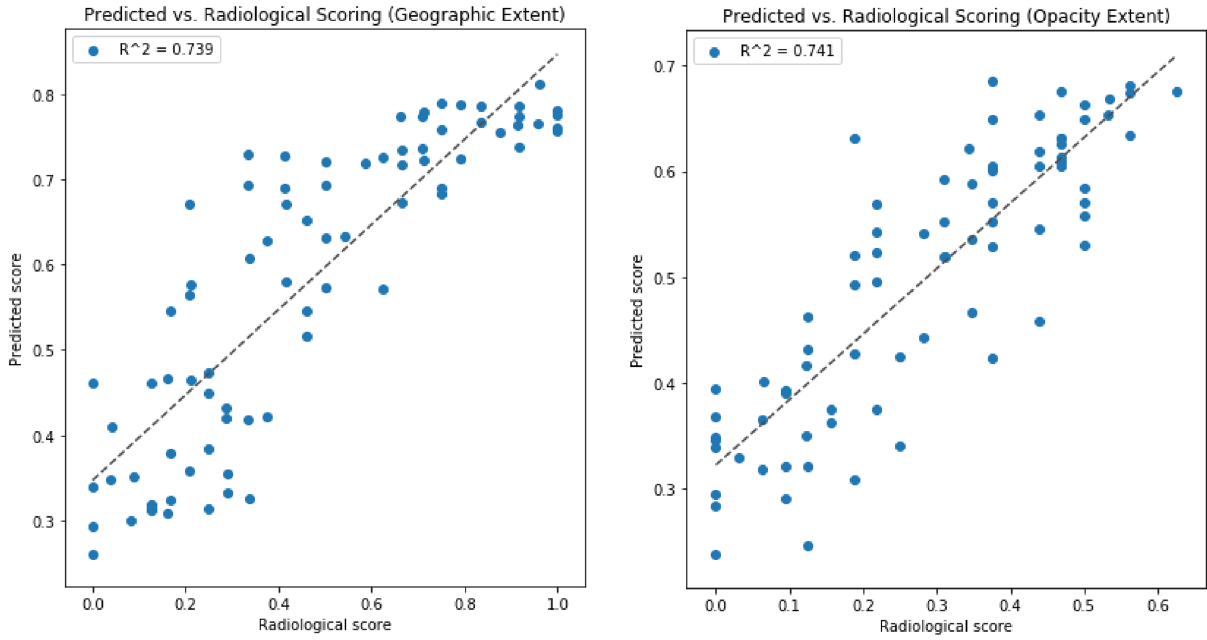
Figure 4. Scatter plots of predicted scores vs. radiologist scores for the best performing networks for geographic extent and opacity extent 2 best performing networks achieved R of 0.739 and 0.741 between predicted scores and radiologist scores for geographic extent and opacity extent, respectively (see Fig. 4 for scatter plots of predicted scores vs. radiologist 2 scores for these networks). Third, the results show that the mean R between predicted scores and radiologist scores for geographic extent is higher than that for opacity extent.